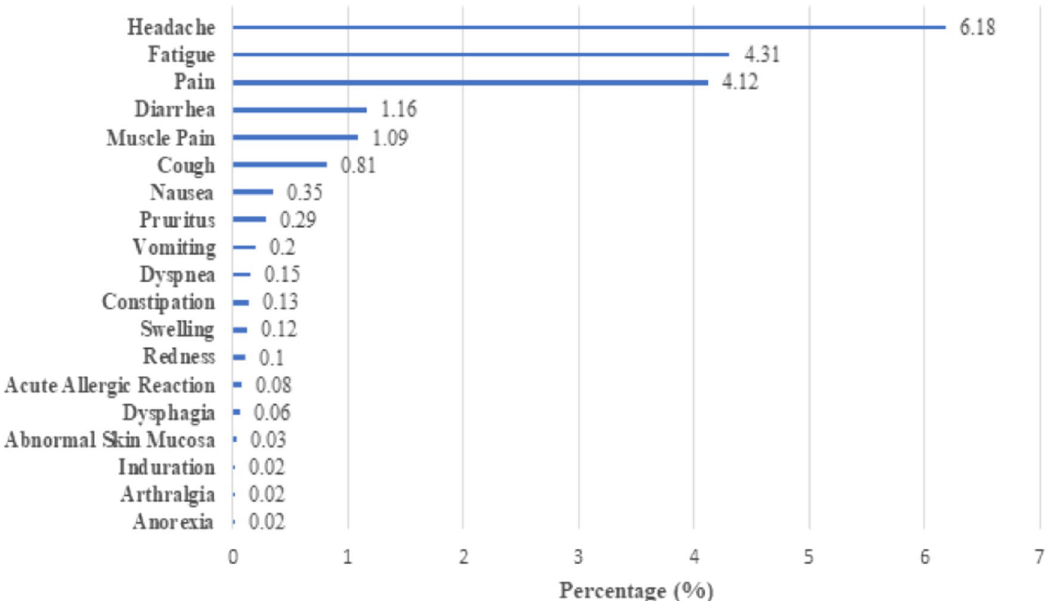
Figure 3. Side effects following